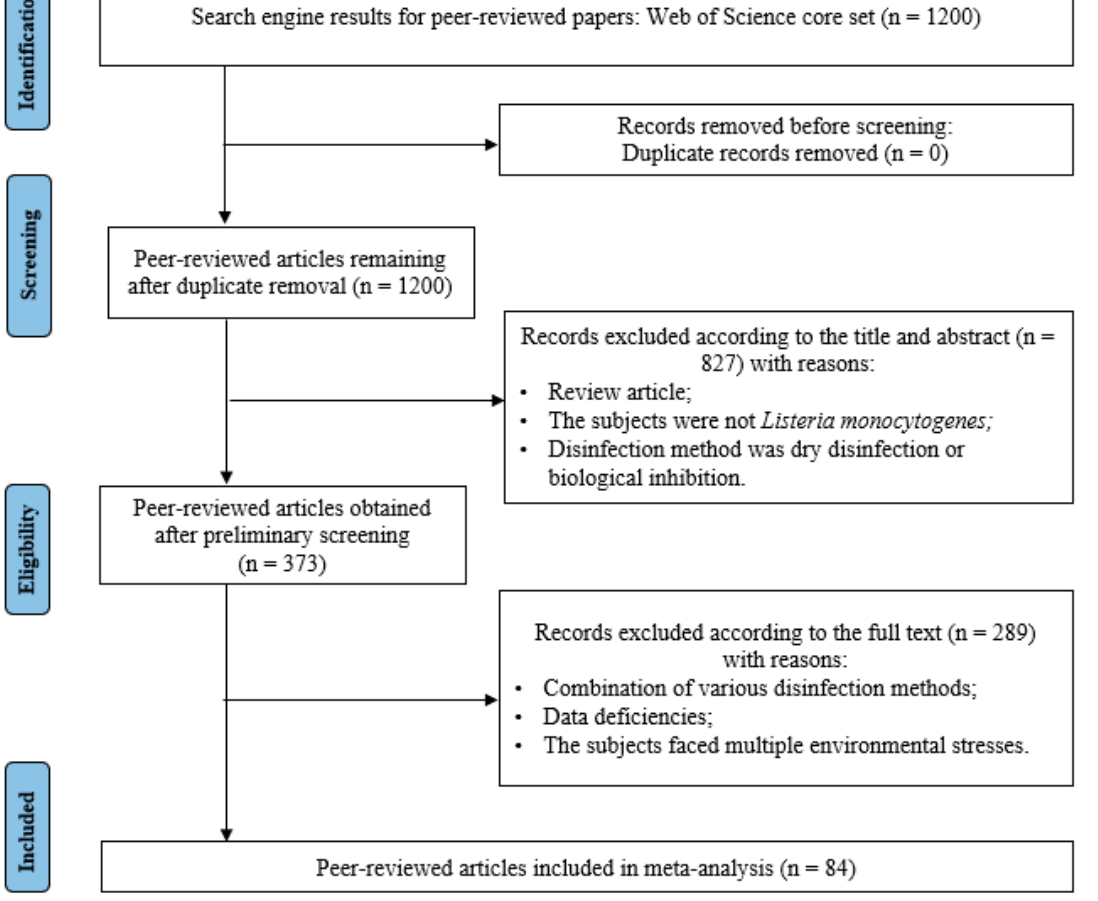
Figure 1. Flow diagram of the systematic review process and the selection of studies for inclusion in the meta-analysis.